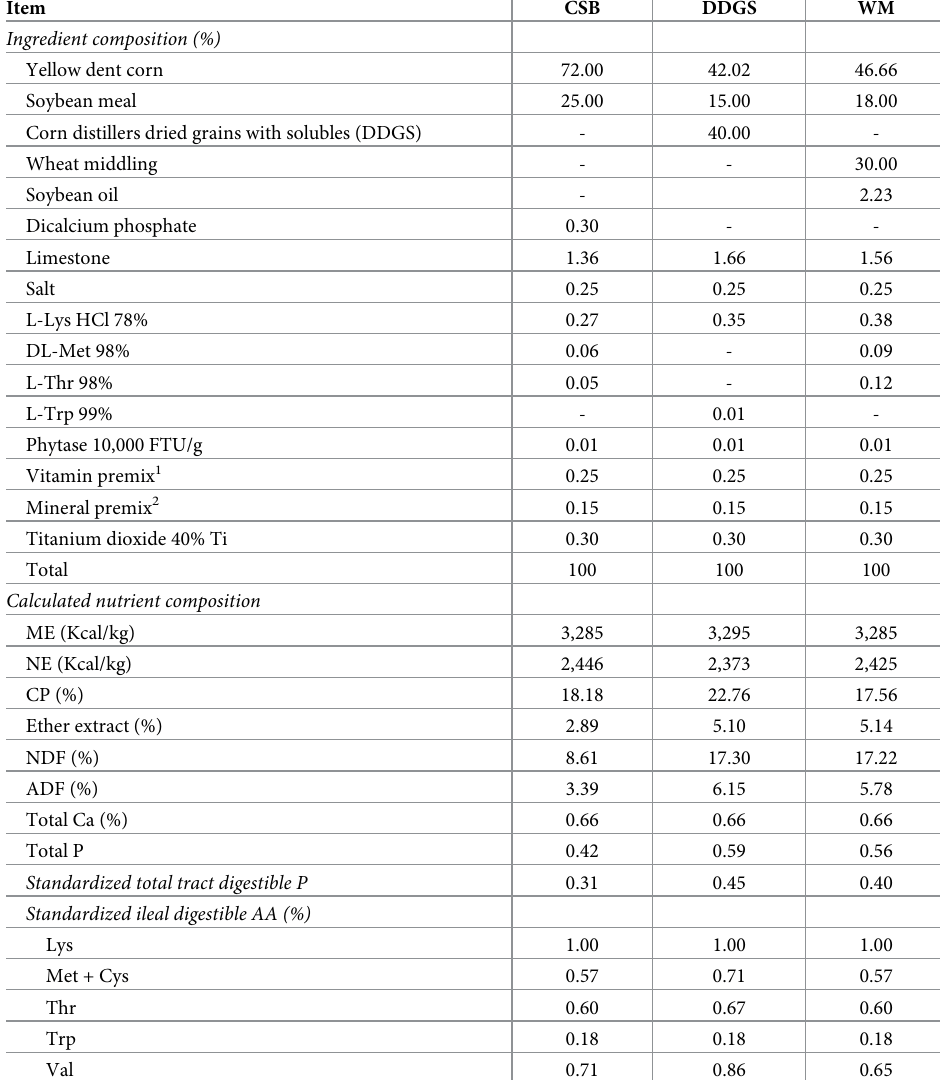
Table 1. Diets formulation and calculated nutrient